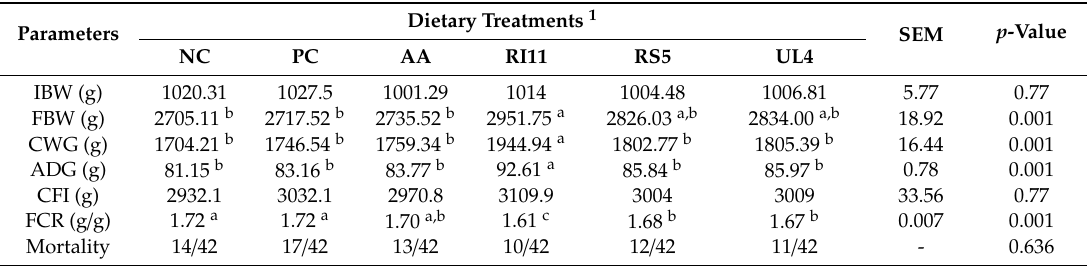
Table 4. Body weight, body weight gain, feed intake, feed conversion ratio, and mortality in broiler chickens fed di ff erent postbiotics under heat